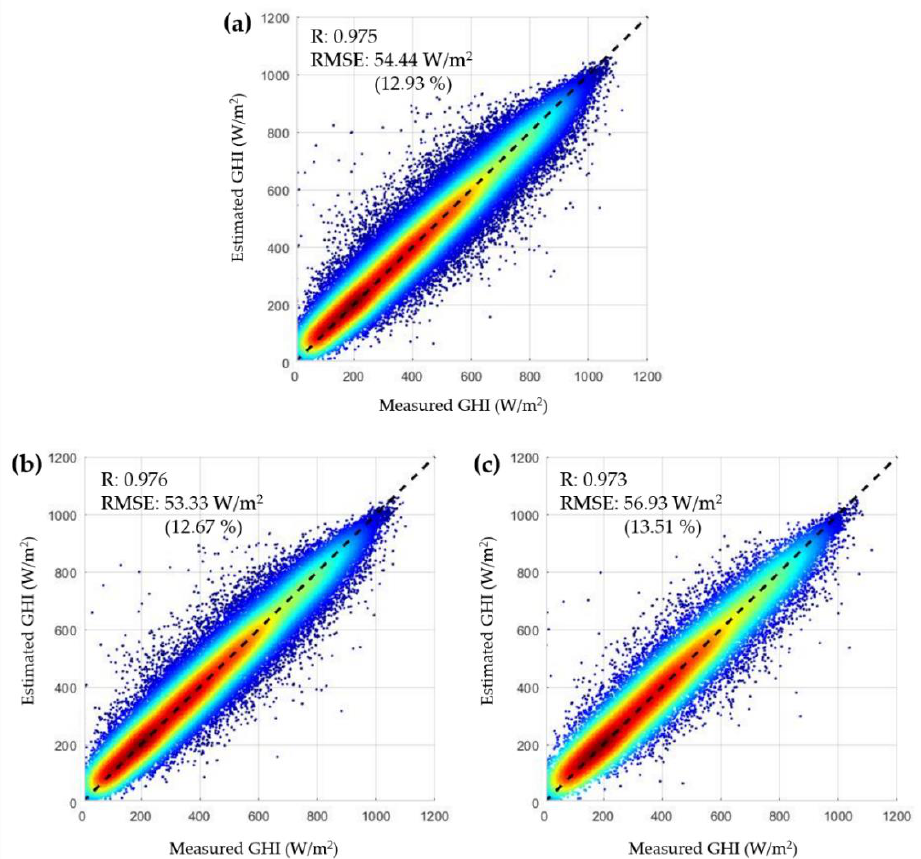
Figure 10. Scatter plots of measured GHI and estimated GHI by the final ANN ensemble model for ( a ) all train and test datasets, ( b ) all train datasets, ( c ) all test